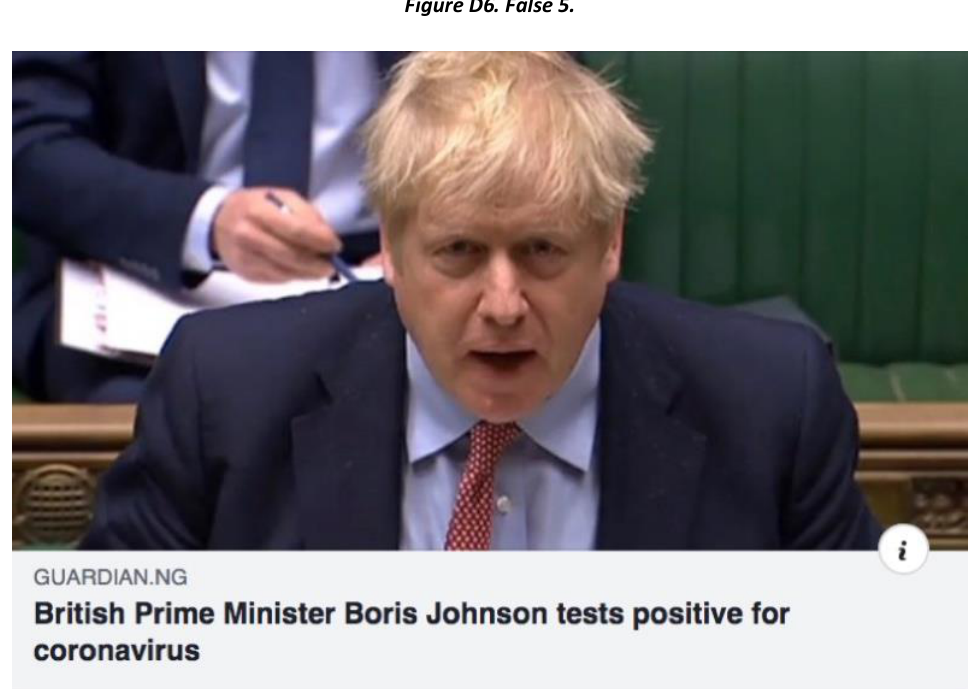
Figure D6. False 5.